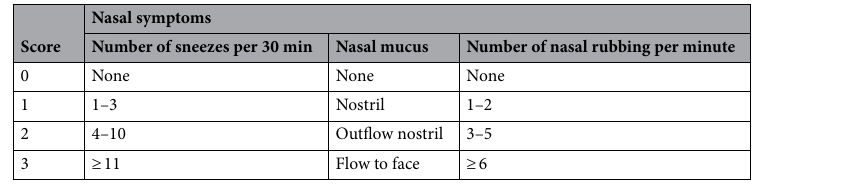
Table 2. Nasal symptom scoring in the AR mouse